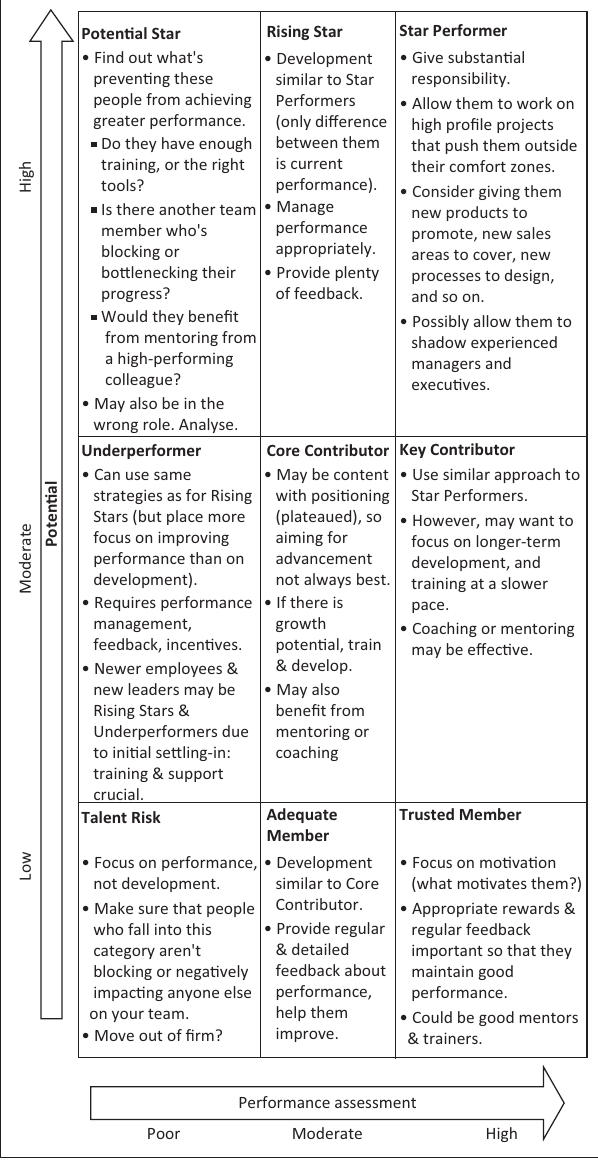
FIGURE 3: Some possible reactions to employees in nine-box grid